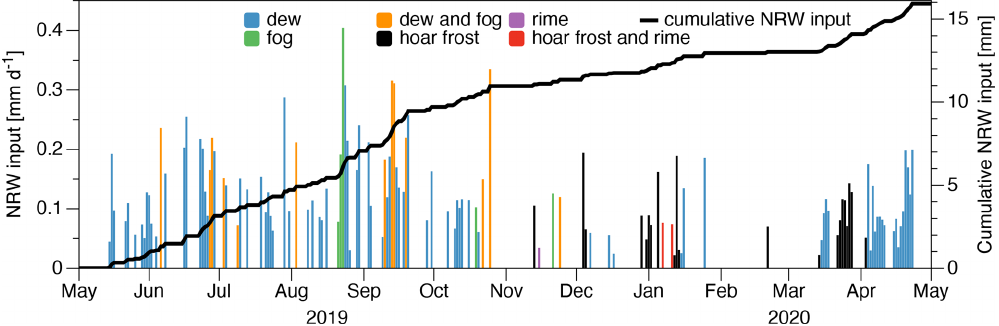
Figure 8. Daily NRW inputs at CH-FRU over 1 year from 2 May 2019 till 2 May 2020. The blue bars indicate NRW events with their corresponding NRW input per day. Different colours indicate different types of NRW inputs. The black line indicates the cumulative NRW